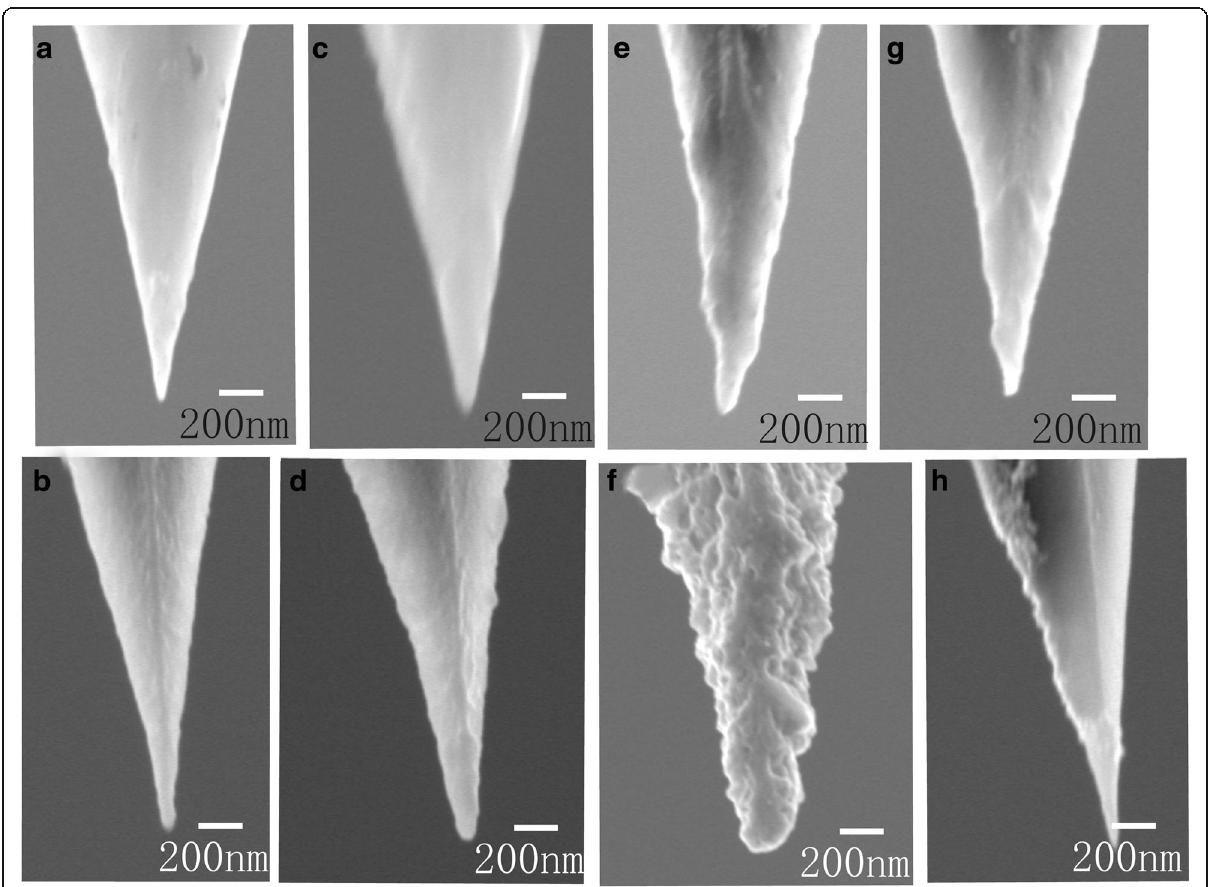
Fig. 2 SEM image of probes prepared by wet-chemical procedures. a Immersion time 10 min, 1 cycle. b Immersion time 5 min, 2 cycles. c